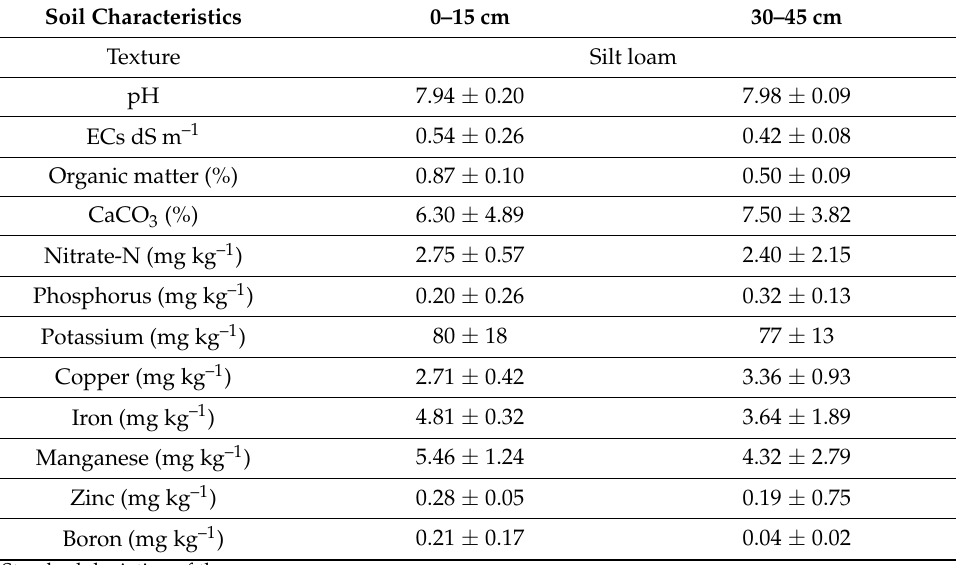
Table 1. The physical and chemical properties of the experimental